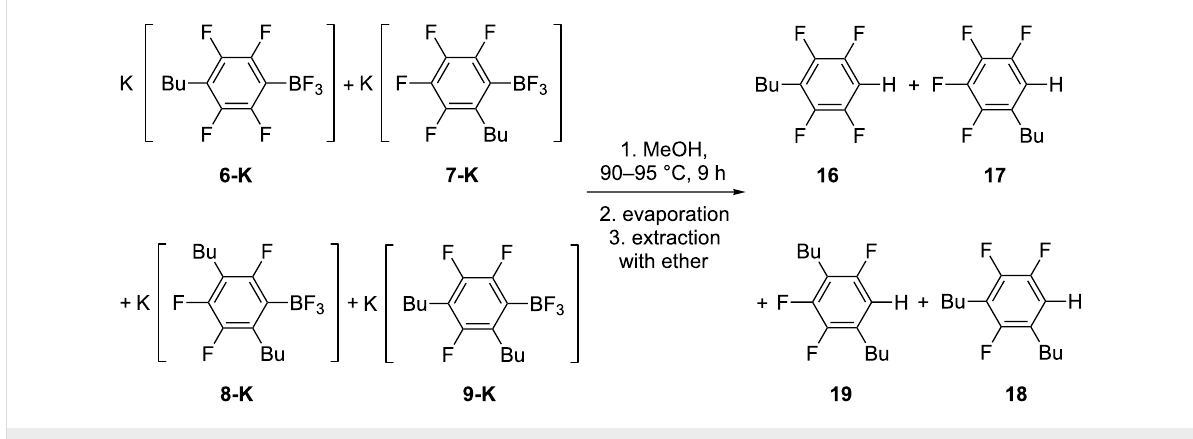
Scheme 5: Hydrodeboration of 6-K , 7-K , 8-K and 9-K in